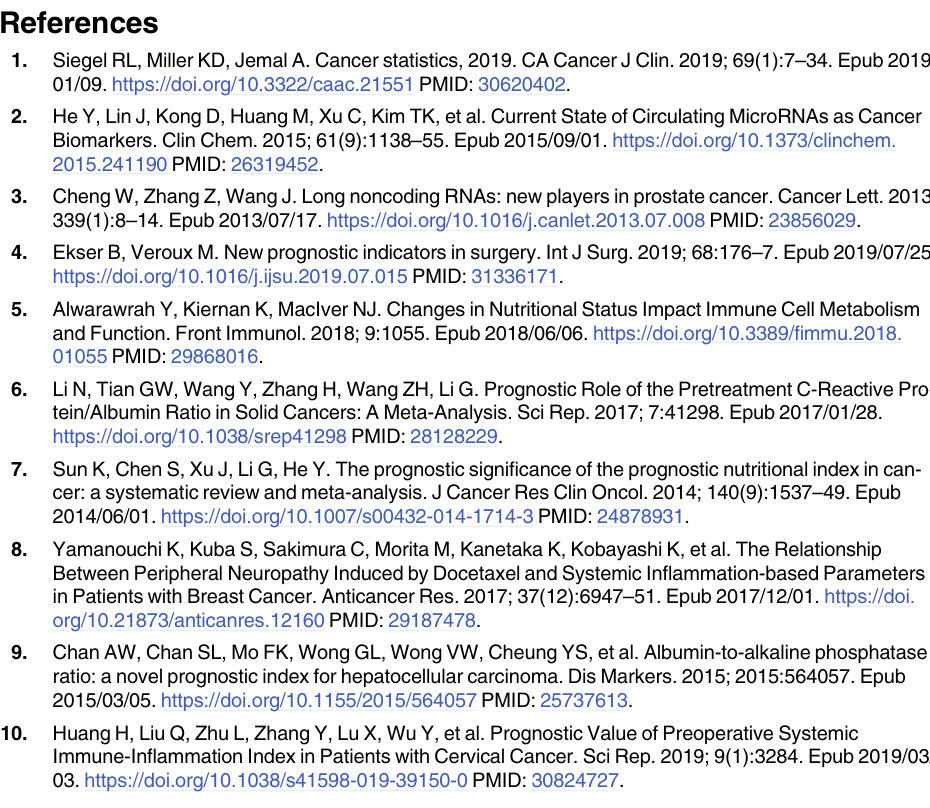
S4 Fig. Forest plot of the association between AAPR and distant metastasis (Yes versus No).